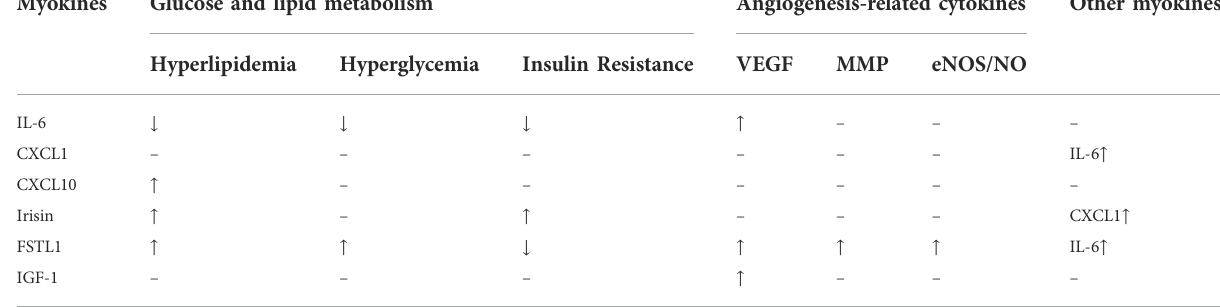
TABLE 2 The mechanisms of myokines in promoting